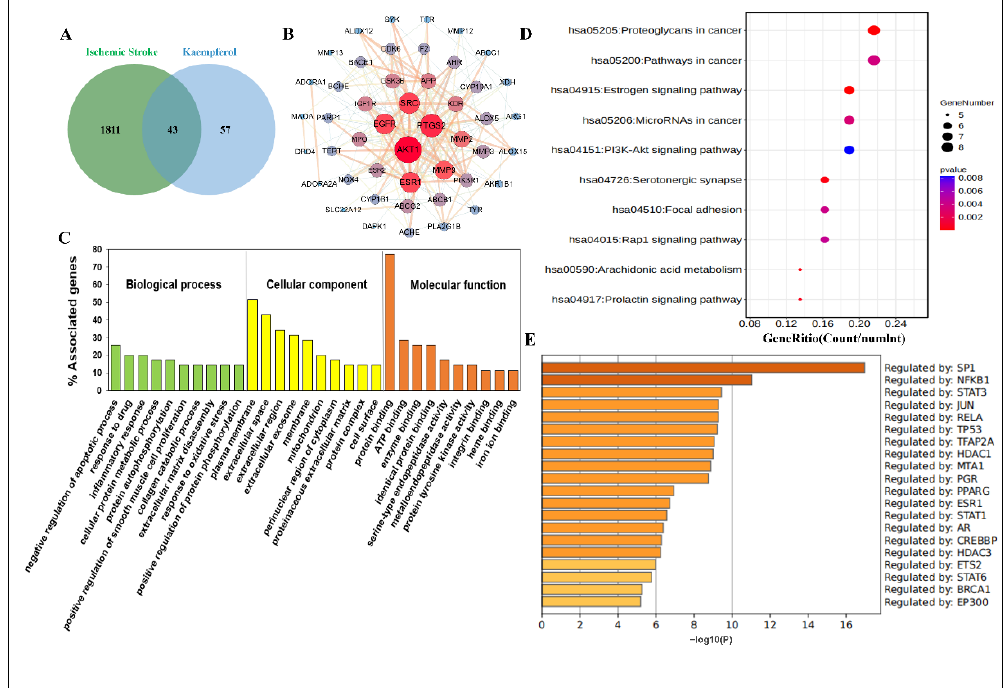
Figure 1. Protein – protein interaction ( PPI) network and enrichment analysis of the anti-ischemic stroke mechanisms of kaempferol. ( A ) 43 common targets of kaempferol and ischemic stroke. ( B ) PPI network plotting of 36 main common targets by employing Cytoscape software. ( C ) The top 10 significantly enriched ( p < 0.05) terms in BP, CC and MF of GO analysis. The Y -axis represents the enrichment count of the target, and the X -axis represents the GO category of the target gene. ( D ) The top 10 pathways with significantly enriched ( p < 0.05) were selected. The Y -axis represents the main pathway, and the X -axis represents the gene ritio. ( E ) The transcription factor enrichment analysis of kaempferol against ischemic stroke in TRRUST using Metascape.